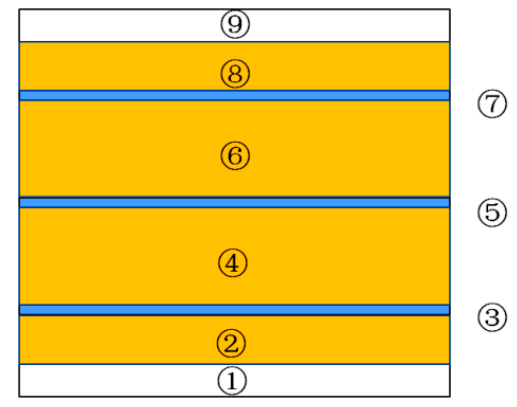
Figure 12. Schematic diagram of the injected medium zoning.